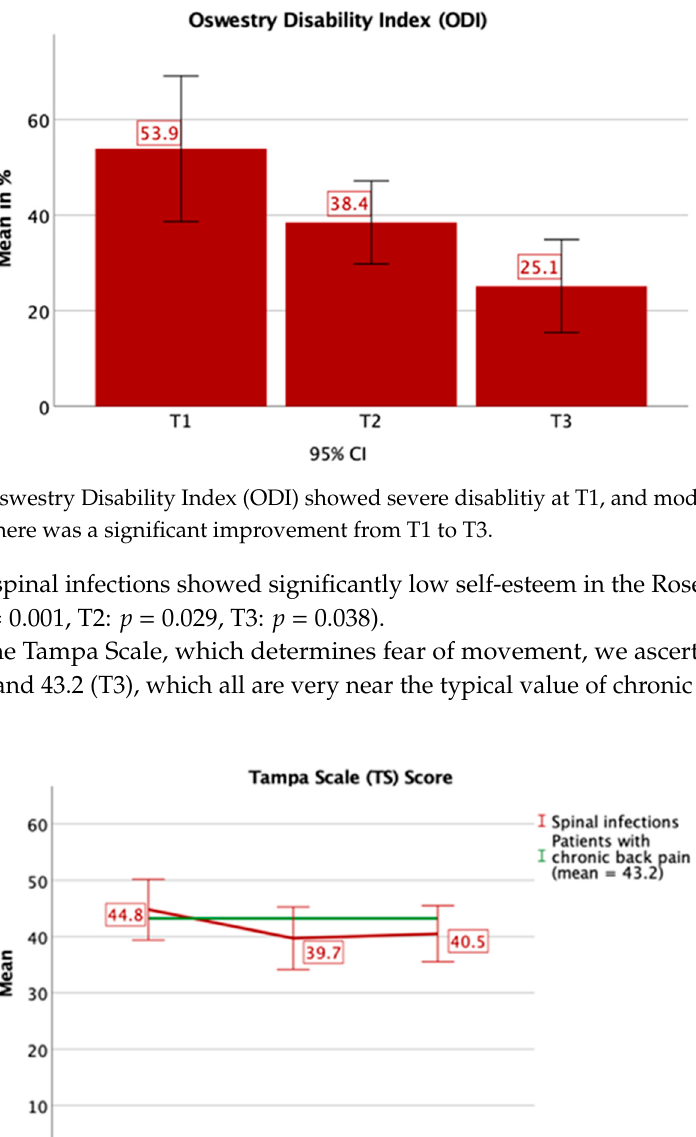
Figure 6. Results of the Tampa Scale are shown, which evaluates fear of movement and (re)-injury. Values of patients with spinal infections were comparable to patients suffering from chronic back pain at T1–T3. CI: confidence interval.